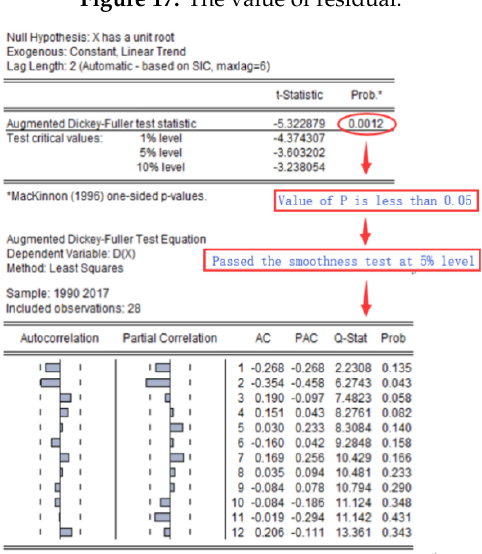
Figure 18. Stationary test result and autocorrelation (partial autocorrelation) map of NMGM ARIMA.